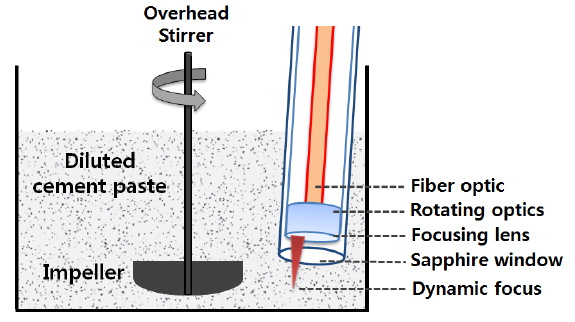
Figure 1. Top-down setup for permanent flocculates.